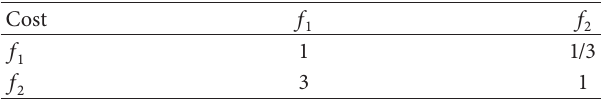
Table 3: Judgment matrix for the cost.